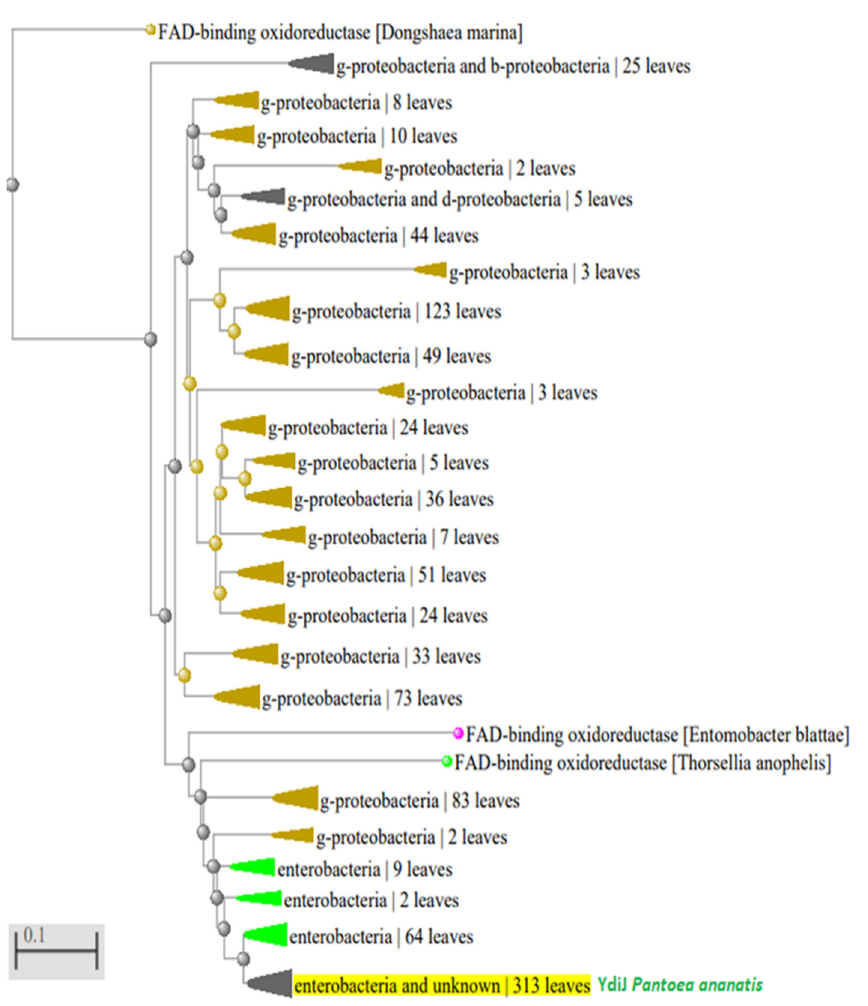
Figure 8. Phylogenetic analysis of D2HGDH Pa distribution in Proteobacteria phylum. Green color: Enterobacteriaceae ; black-yellow color: gamma Proteobacteria ; fuchsia color: alpha Proteobacteria . D2HGDH Ps is also an enzyme from the Proteobacteria phylum. From 1000 analyzed